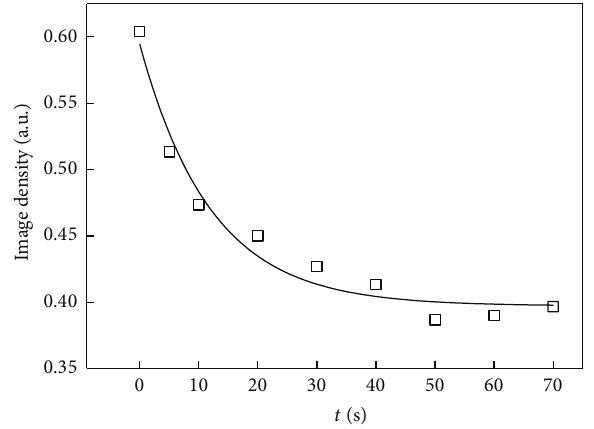
Figure 9: Image density variance of the microcapsules exposed at different time and then thermally processed at 150 ∘ C.